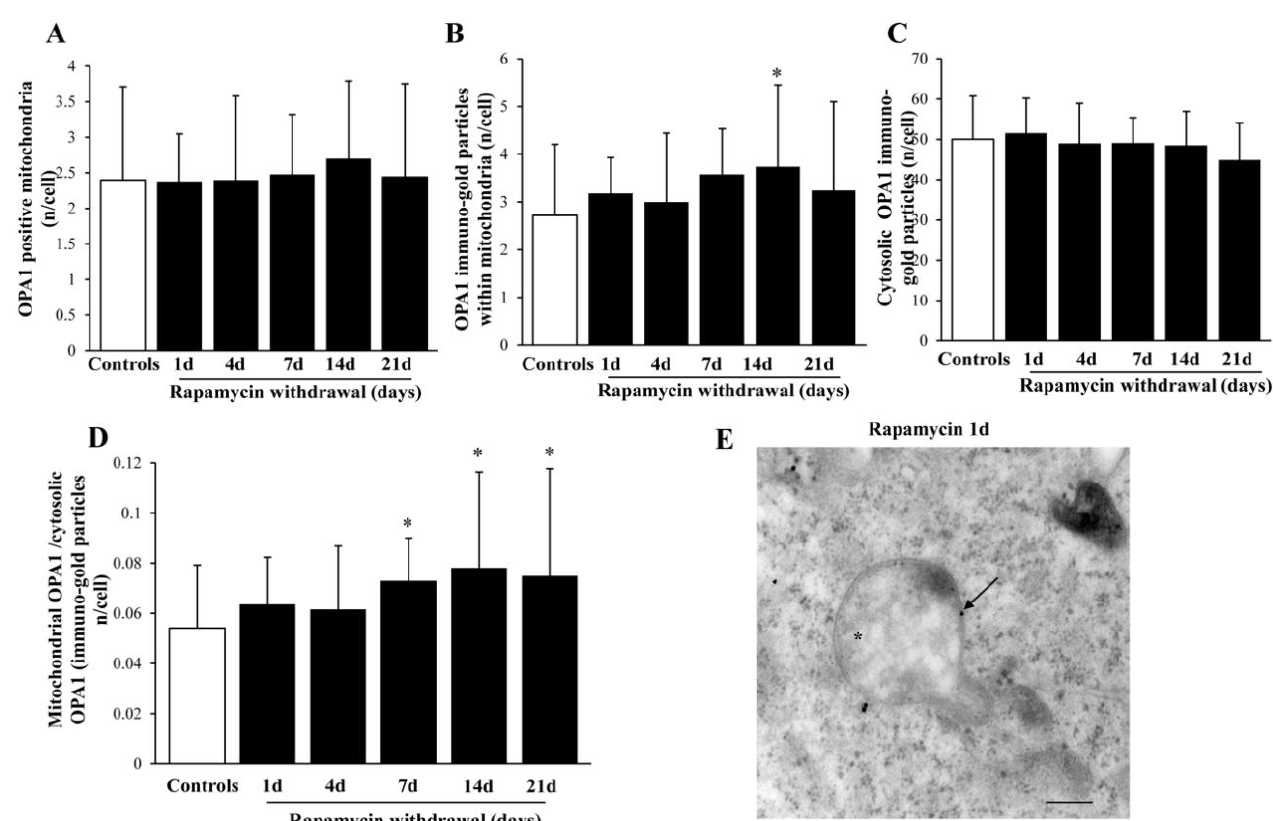
Figure 13. Rapamycin increases the combination of fission markers FIS1 and DRP1. ( A ) Representative mitochondrion double stained for FIS1 and DRP1 immuno-gold particles (20 nM, arrowhead, and 10 nM, arrows respectively) following 1 d rapamycin withdrawal. Graph ( B ) reports FIS1+DRP1-positive mitochondria. Values reported in the graph correspond to the mean ± SD. Mitochondria were counted in 50 cells per group. * p ≤ 0.05 compared with controls. Scale Bar = 0.25 μ m, Asterisk (*) = mitochondria, ER = endoplasmic reticulum.